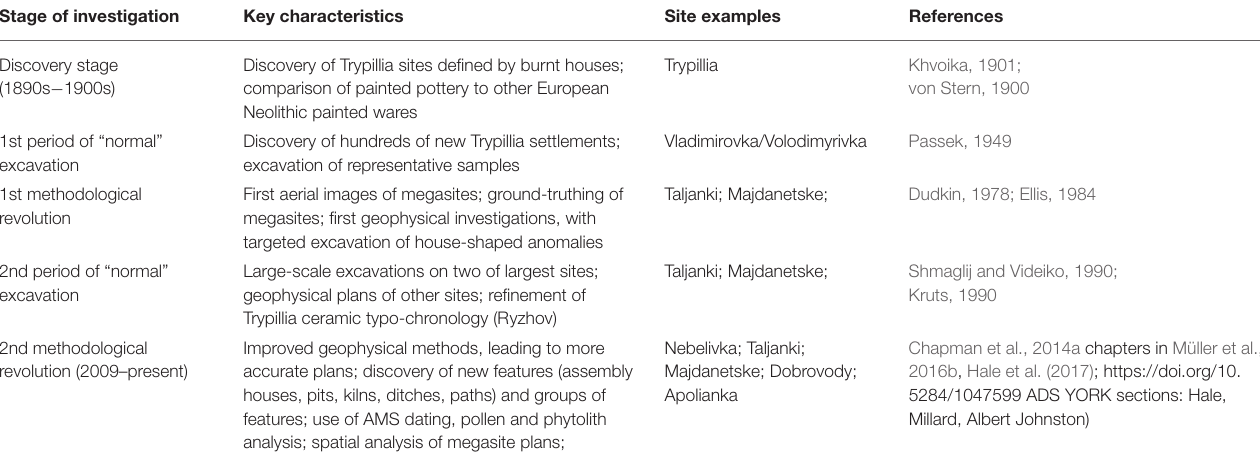
TABLE 1 | The main stages of investigation of Trypillia